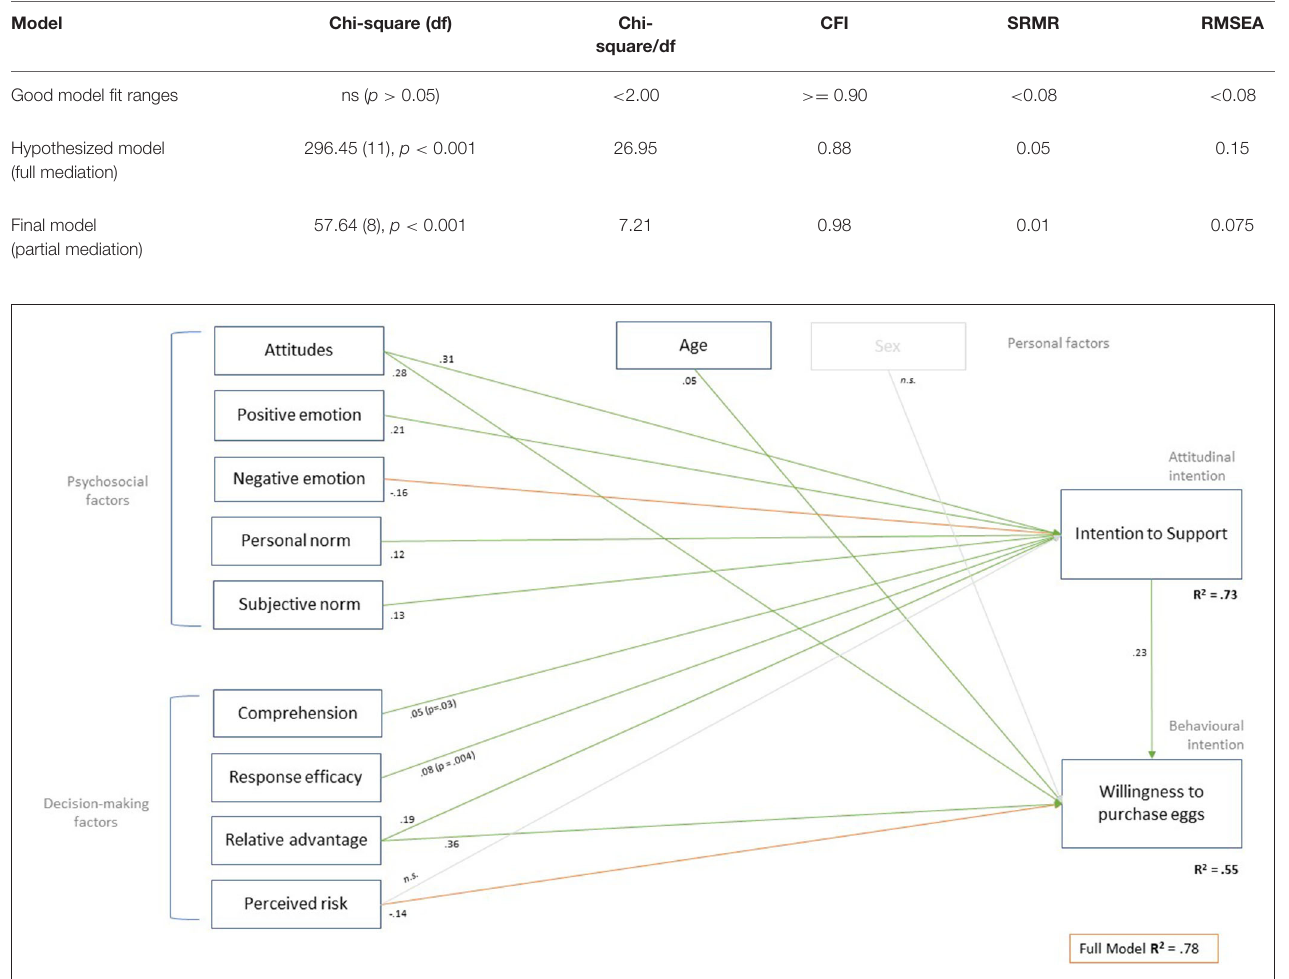
FIGURE 5 | A path model of psychosocial, decision-making, and personal factors predicting public support for development of gene marking technology and willingness to purchase eggs derived from this novel approach. All coefficients listed are significant at p < 0.001 unless